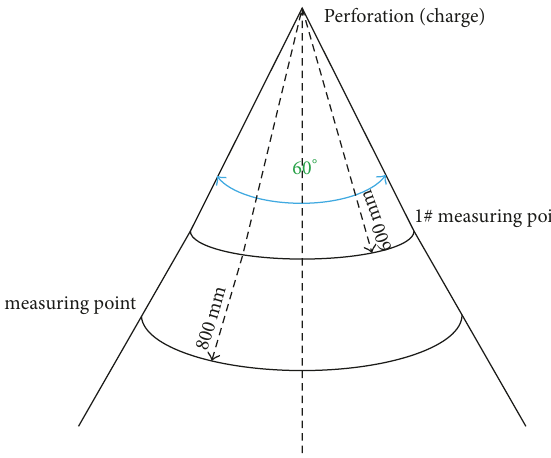
Figure 10: Arrangement diagram of pressure